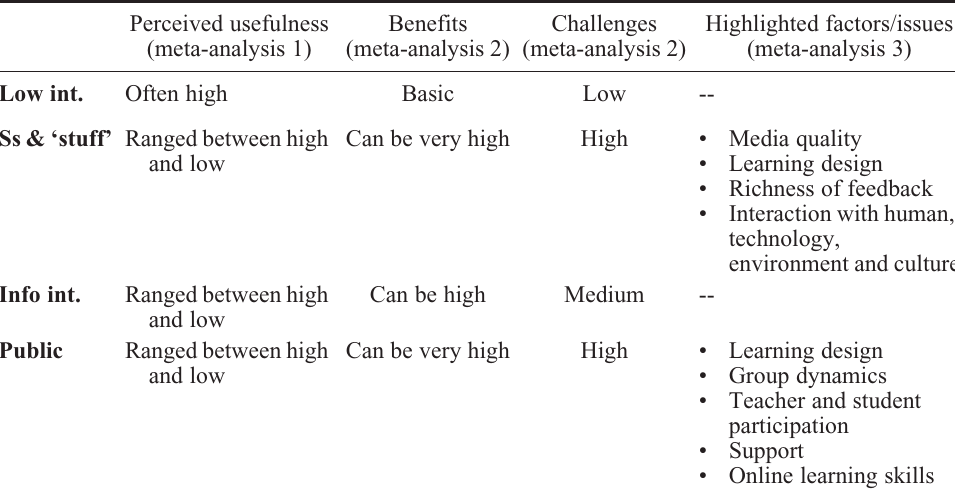
Table 6. Combined observations in the three meta-analysis